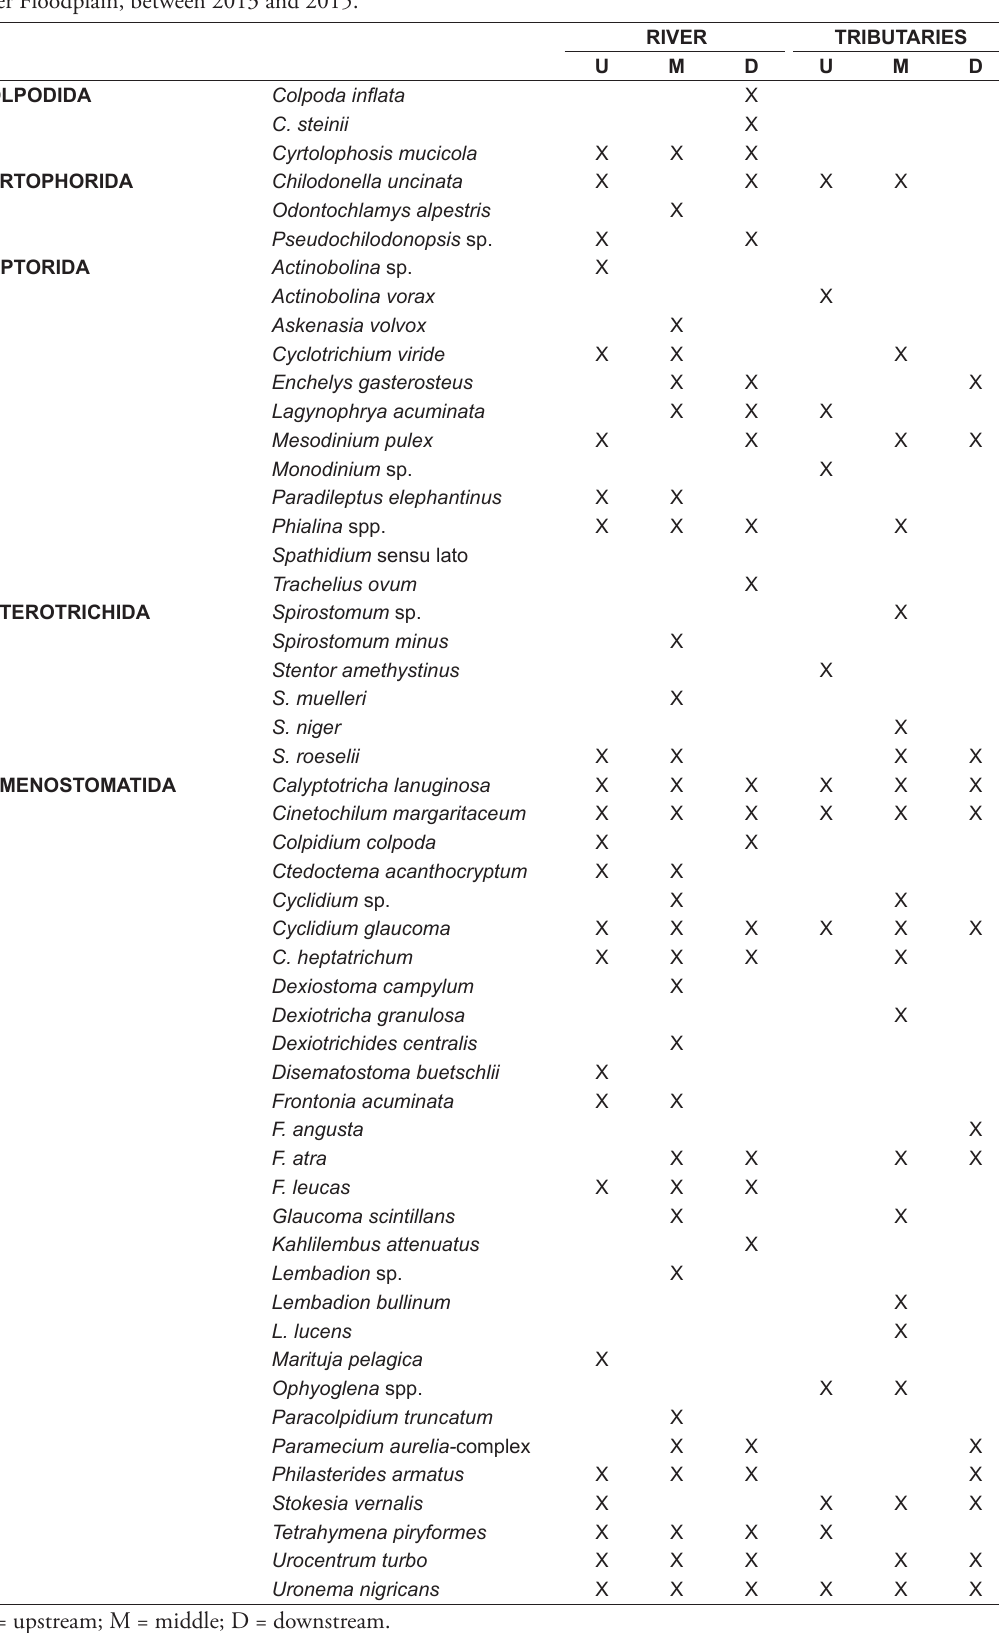
Table 1. Ciliate species list recorded in distinct environments – main river and tributaries – of the Upper Paraná River Floodplain, between 2013 and 2015.